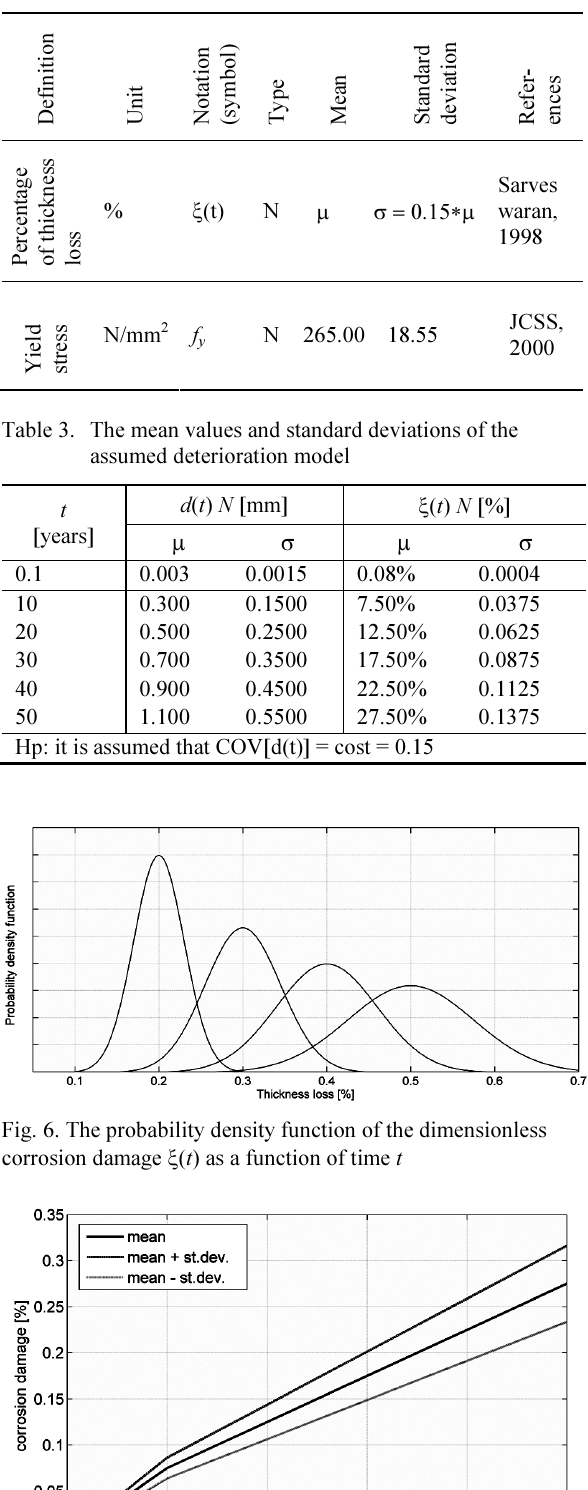
Table 2. Random variables used in the reliability analysis of cold-formed C-lipped section